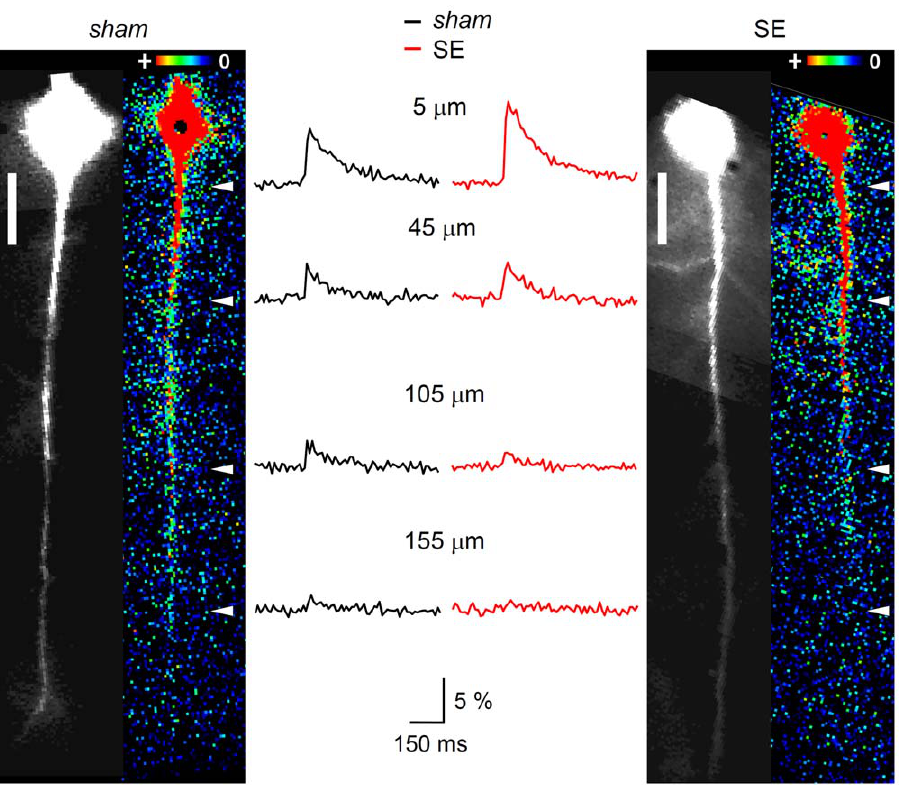
Figure 5. B-AP imaging in the apical dendrite of CA1 pyramidal cells. The retrograde spread of excitation in the apical dendrite of CA1 pyramidal cells was studied with the Ca 2 + imaging technique. A and C , left (black-and-white images). Sham and SE cell, respectively, filled with bis- Fura 2 via a somatic patch-pipette (not shown); scale bars: 25 m m. A and C , right (false color images). Same sham and SE cell, respectively, during backpropagation of an AP, which was generated by somatic current injection. The maximal Ca 2 + signal (absolute fluorescence change, D F) caused by the b-AP along the apical dendrite is color-coded (see insets): red ( + ) represents large, dark blue low changes in fluorescence. B . Corresponding Ca 2 + transients ( D F/F in %) recorded from the sham (black) and the SE cell (red) shown in A and C, respectively, at 5, 45, 105 and 155 m m from the soma (see white arrowheads in A and C, right). Note that, despite the larger amplitude of the Ca 2 + signal next to the soma, its decrease along the apical dendrite was stronger in the SE cell than in the sham cell.